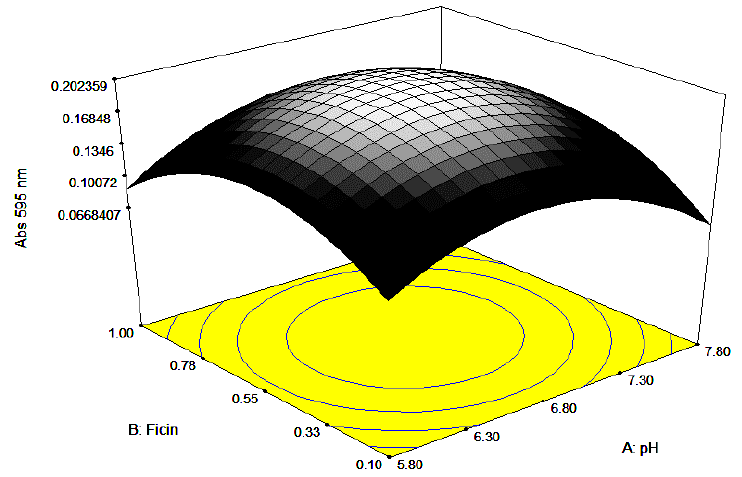
Figure 5. Model diagnostic plots; ( a ) predicted versus actual, ( b ) studentized residue versus predicted, ( c ) normal plots of residue and ( d ) outlier T versus run.